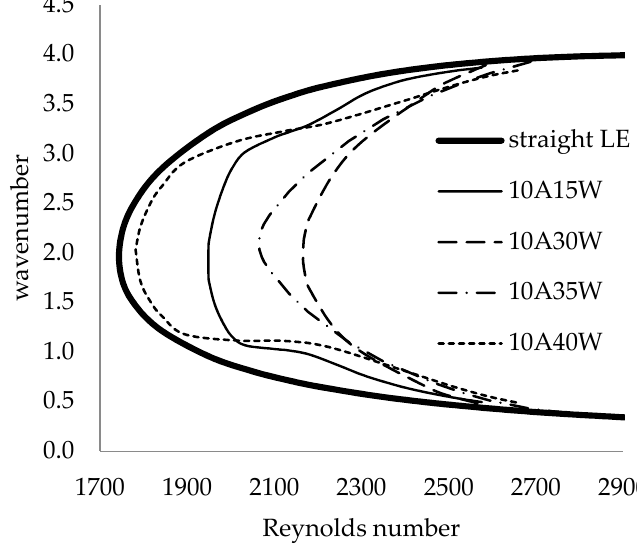
Figure 17. Neutral curves for 42.5° swept flat plate with different leading-edge wavelengths at fixed amplitude of 10% chord, along with straight leading-edge neutral curve.